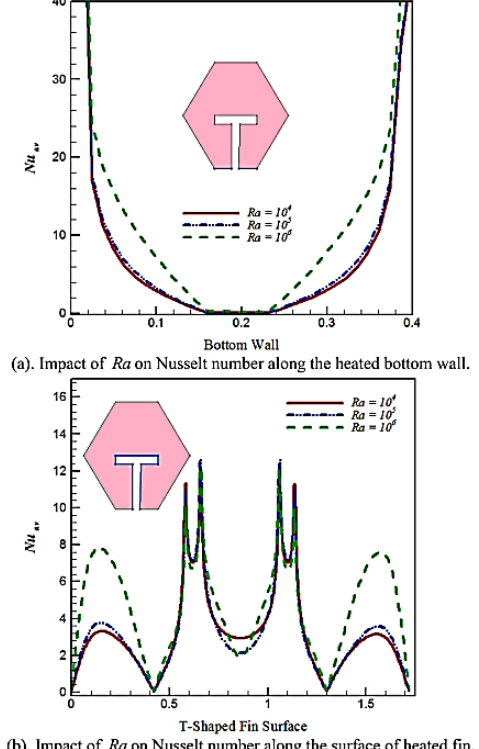
Figure 16. Impact of Ra on Nusselt number. Reprinted with permission from Ref. [37]. 2020, Elsevier.